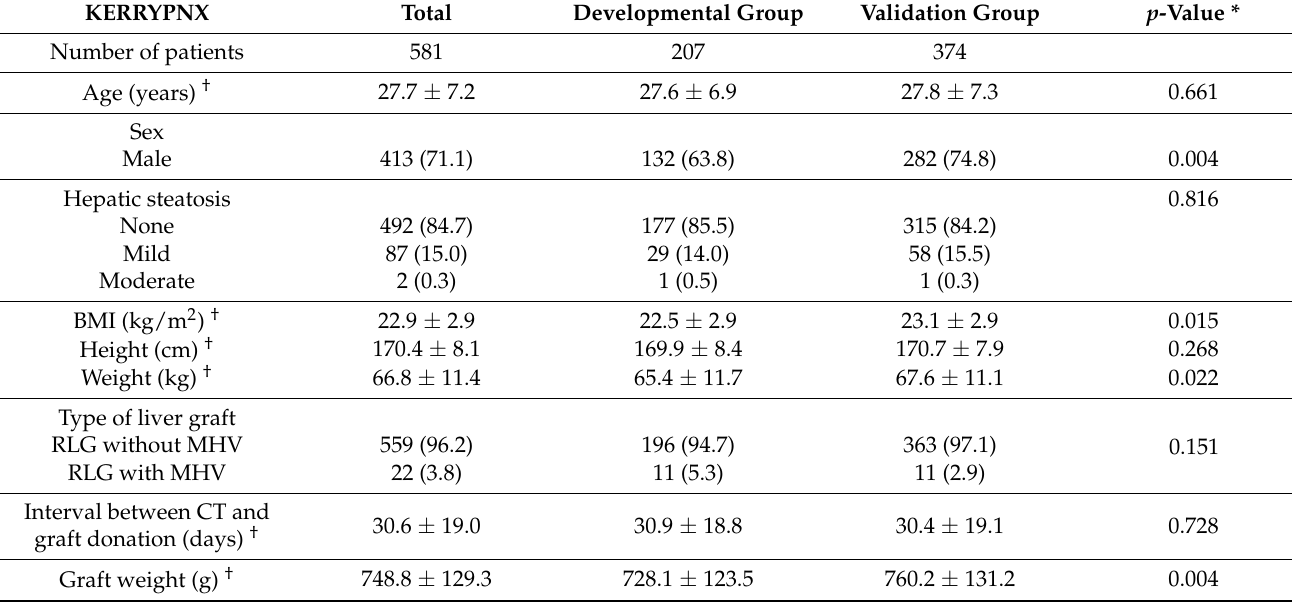
Table 1. Characteristics of the study